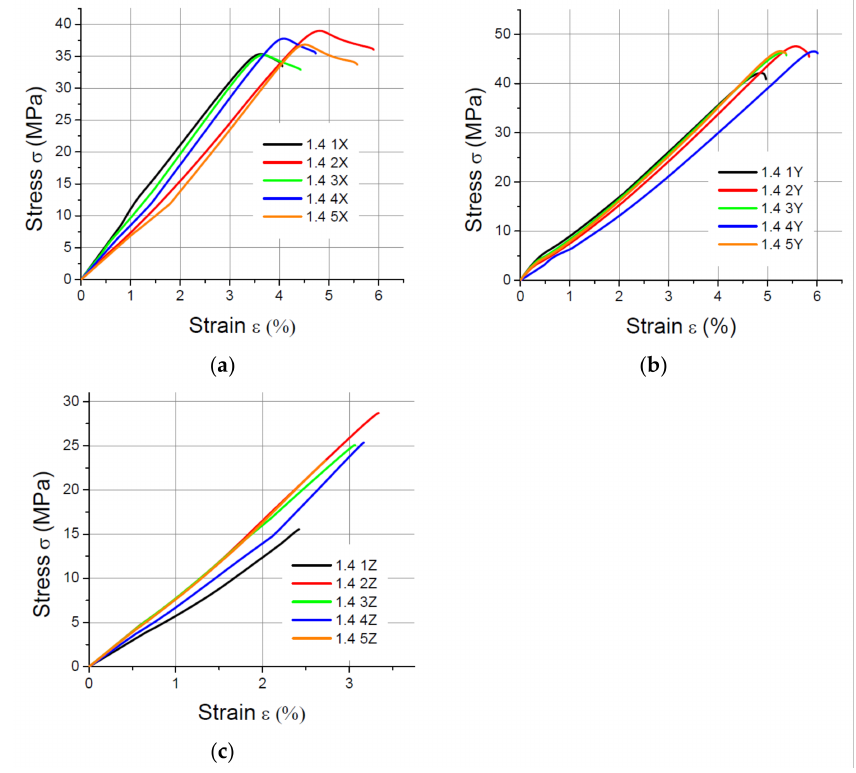
Figure 5. Tensile test results for 1.4 mm thick specimens made of PLA printed in ( a ) the X orientation; ( b ) the Y orientation; ( c ) the Z